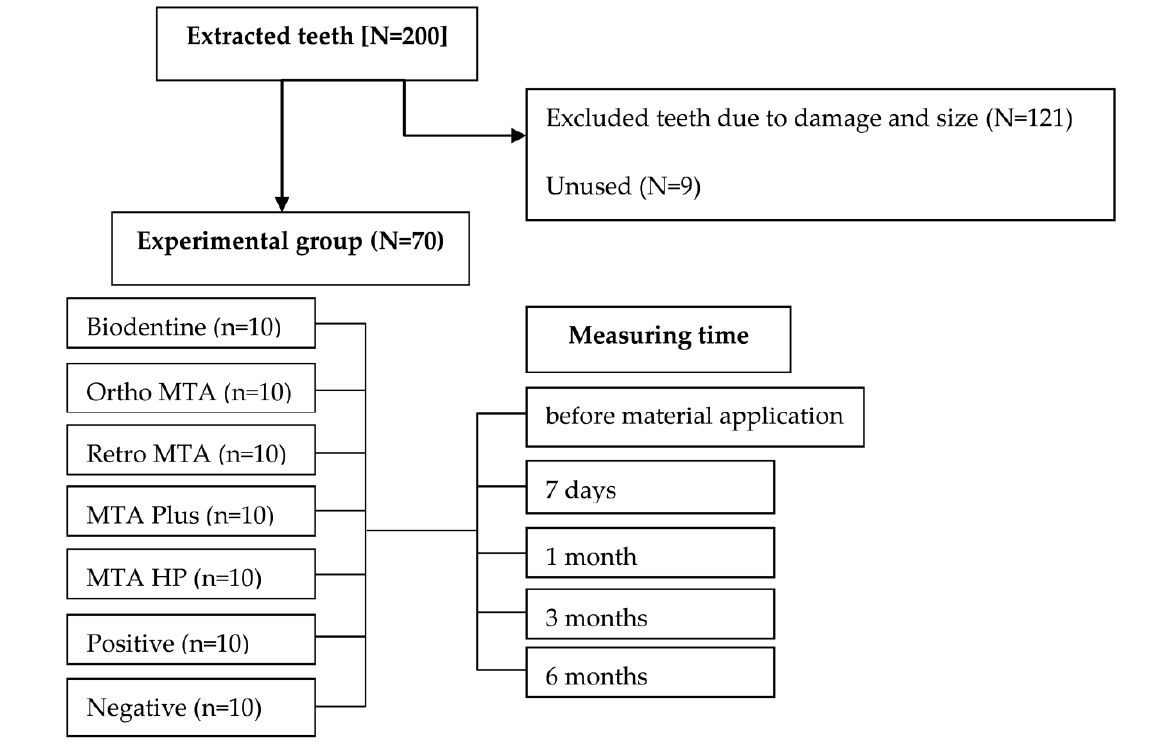
Figure 1. Description of experimental groups. Table 1. Compositions of the CSCs considered in this study.